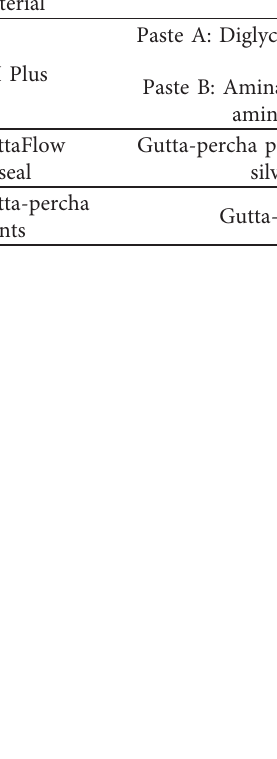
Figure 1: Experimental setup and groups. Experimental groups consisted of root canal-filled teeth with GP cone and sealer and a GP cone- inserted sealer mass. Positive control groups consisted of root canal-filled teeth with GP cone, and sealer masses acted as negative controls.